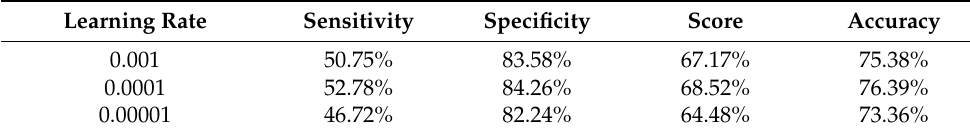
Table 3. Proposed model’s performance for different learning rates.